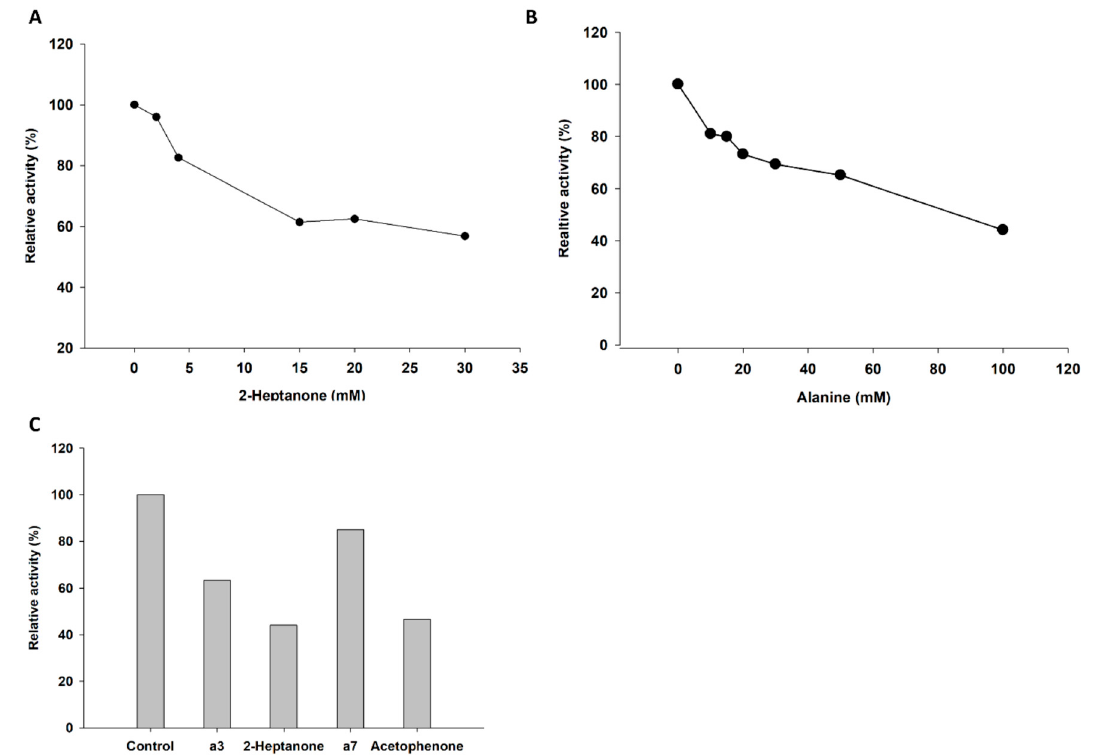
Figure 6. Inhibition of Rs-AmDH by ( A ) 2-heptanone; Reaction conditions- 10 mM rac- a3 , 0–30 mM 2-heptanone, 1 mM NAD + , 0.2 mg / mL Rs-AmDHs, Bu ff er- Glycine bu ff er (100 mM, pH 9.5); ( B ) Alanine; Reaction conditions- 10 mM rac- a3 , 0–100 mM alanine, 1 mM NAD + , 0.2 mg / mL Rs-AmDHs, 100 mM Glycine bu ff er (pH 9.5) and ( C ) Inhibition of AlaDH by amines rac- a3 and rac- a7 ; and ketones 2-heptanone and acetophenone (10 mM each), Control-activity of AlaDH in the absence of amines and ketones.